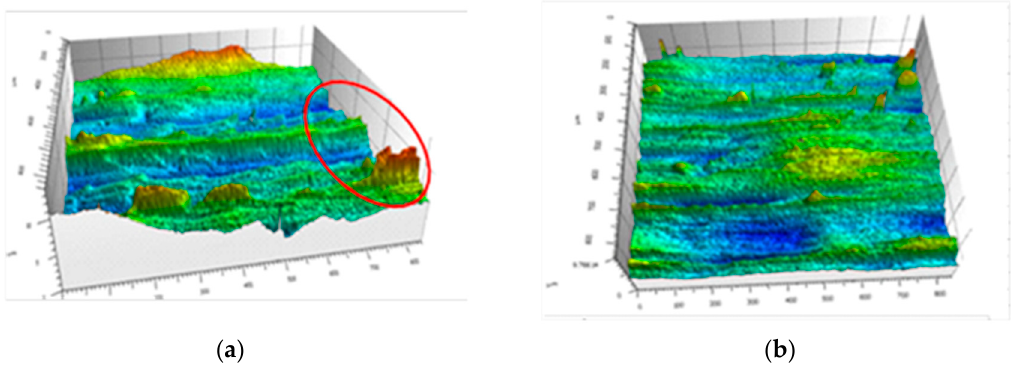
Figure 9. Workpiece surface morphology. ( a ) 175 μ m; ( b ) 200 μ m.